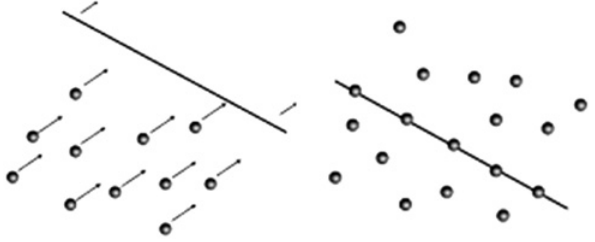
Figure 2: Diffusion of alloying atoms towards mobile dislocations (DSA).